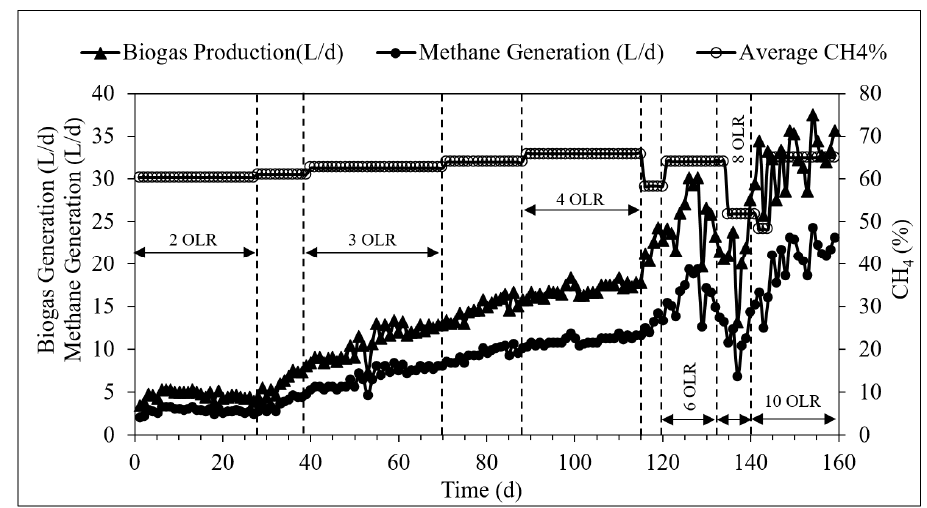
Figure 3. Variation of biogas production and methane generation during the reactor operation.